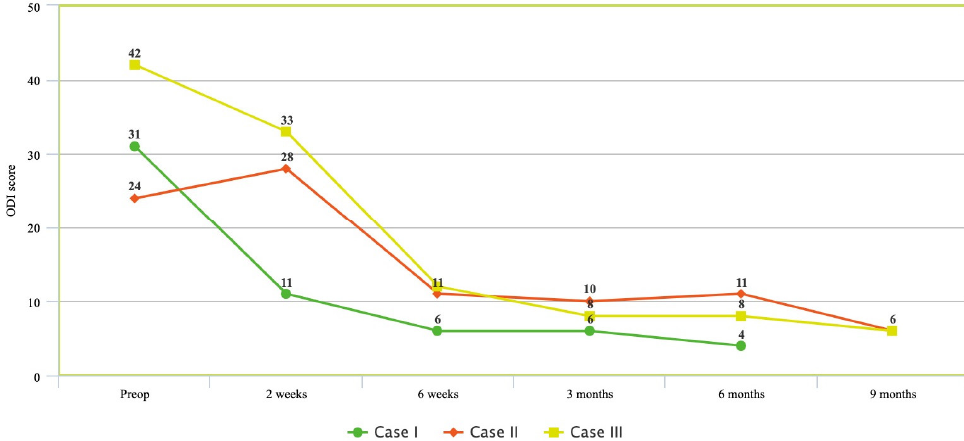
Figure 2. Oswetry disability index (ODI) changes over time for patients pre-operatively and at